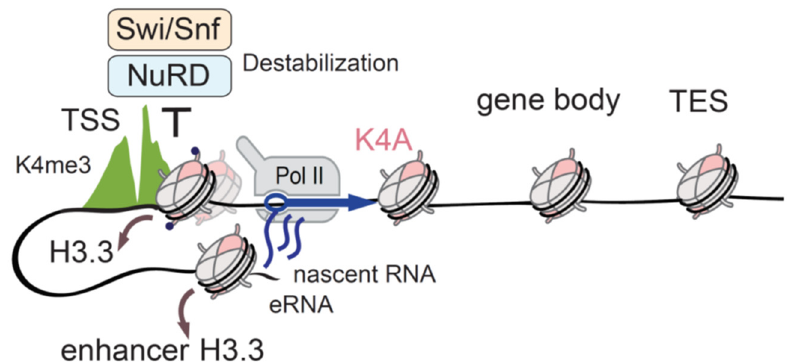
Figure 3. Identifying H3.3K4 function with endogenous H3.3 mutation. The unstable H3.3K4A (pink) mutant is depleted from TSSs and enhancers (brown arrows), but H3K4me3 levels (green) are unchanged due to the existence of the canonical histone H3.1 / H3.2. The recruitment of the chromatin remodelers NuRD (light blue) and Swi / Snf (light orange) to the regulatory regions is perturbed in H3.3K4A ESCs, because these complexes require the K4 residue for binding to the H3 histone tail. The disturbed remodeler occupancy results in the misregulation of Pol II activity (blue arrow), and aberrant transcription from TSS and linked enhancers. H3.3 mutation helped with the clarification of the functional role of the H3K4 residue in chromatin regulation and transcription. Transcription start sites (TSS); Transcription end sites (TES); Enhancer